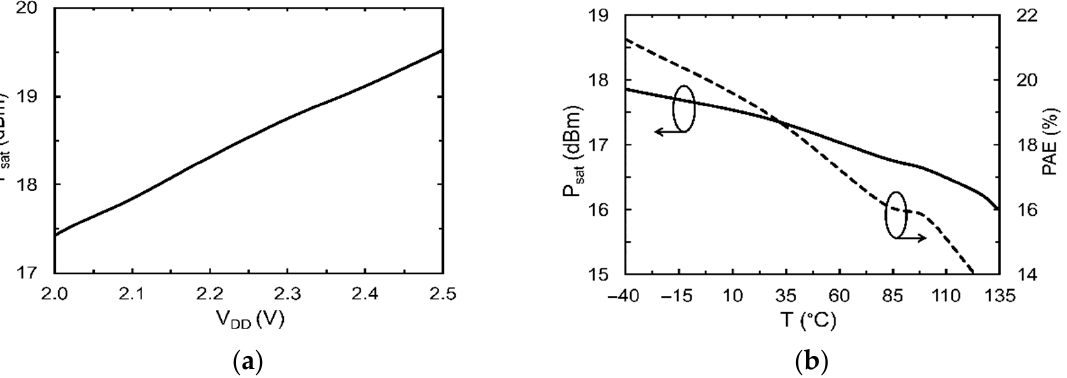
Figure 7. ( a ) Measured PA output power and PAE versus input power. ( b ) Measured peak detector voltage versus output power.